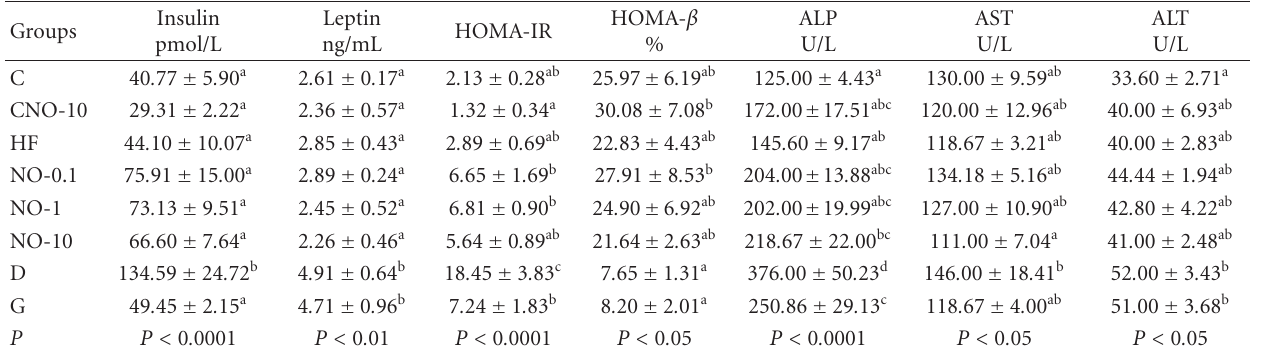
Table 4: Values of HOMA-IR, HOMA- β , insulin, leptin, and liver enzymes of groups at the end of the experimental period. Groups